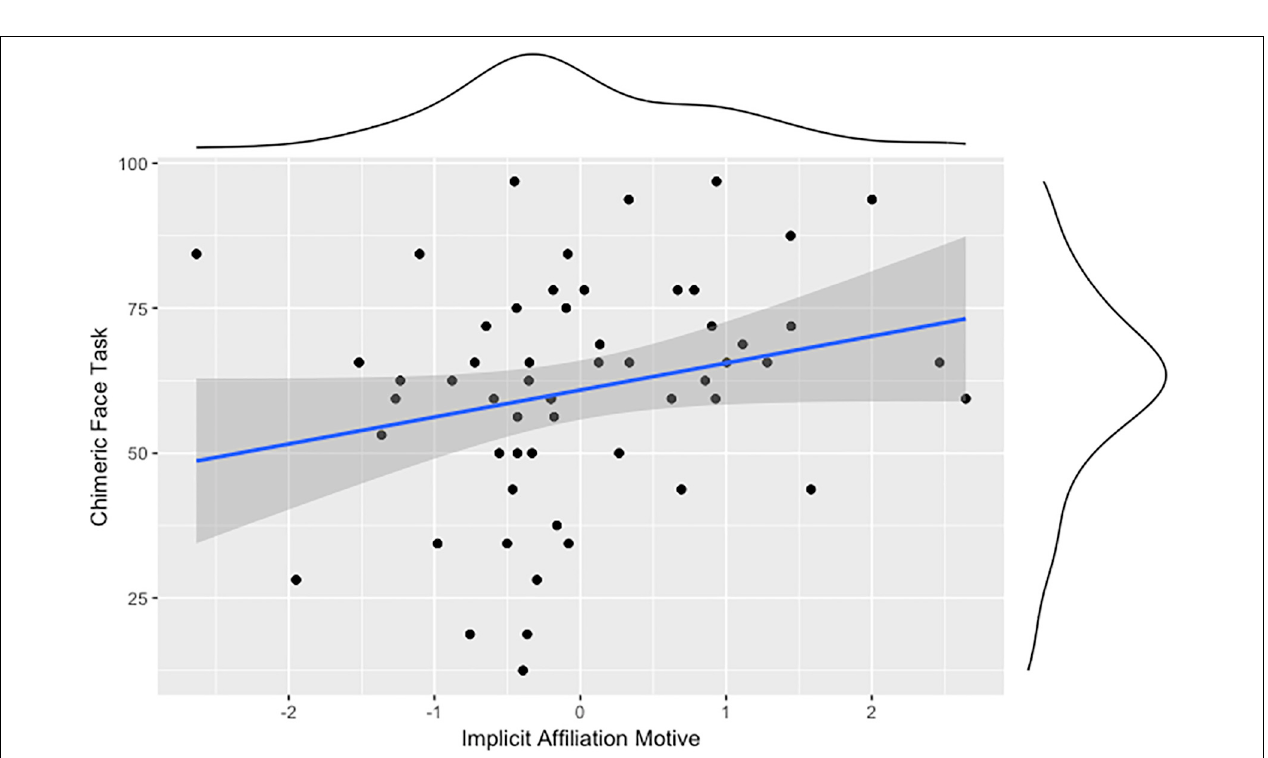
FIGURE 2 | Association between the implicit affiliation motive and cognitive-behavioral indicators of rightward brain laterality (CFT).